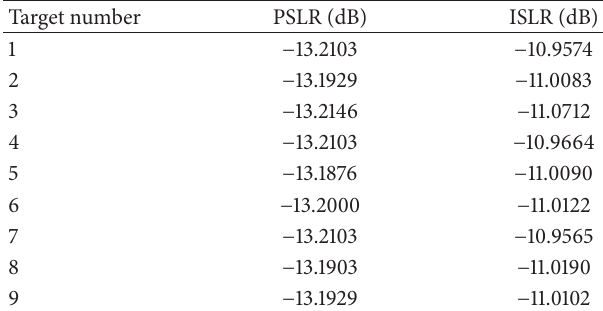
Table 2: Side lobe property of